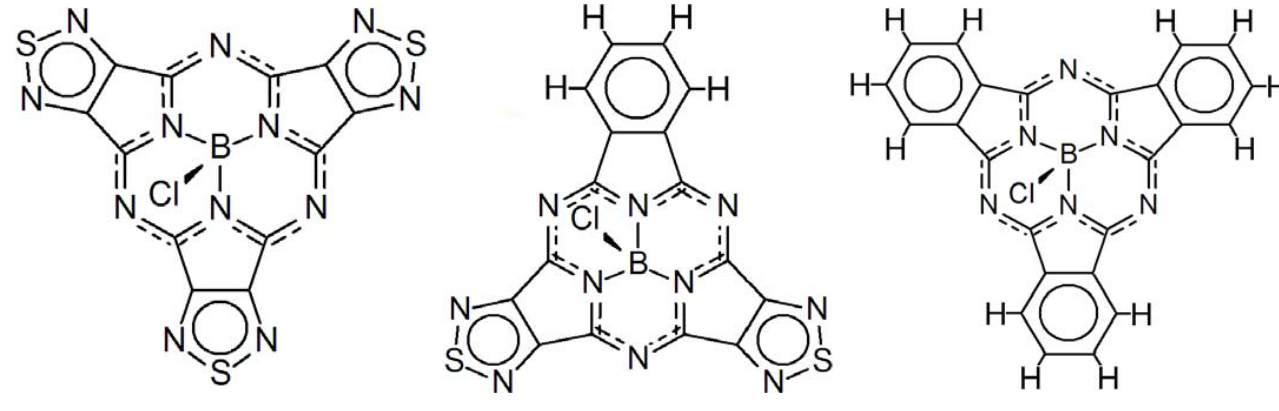
Figure 1. Molecular structures of compounds used in this